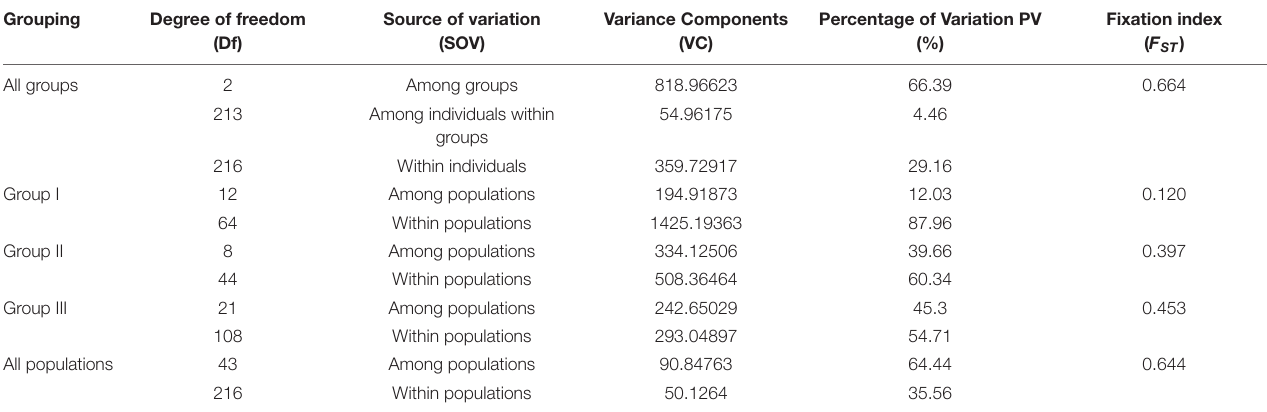
FIGURE 4 | Principal components analysis of 44 E. sibiricus populations. Each circle represents an individual, and the circle color represents the population attribute of each individual. TABLE 2 | Results of hierarchical AMOVA for 44 populations of E. sibiricus sampled within four